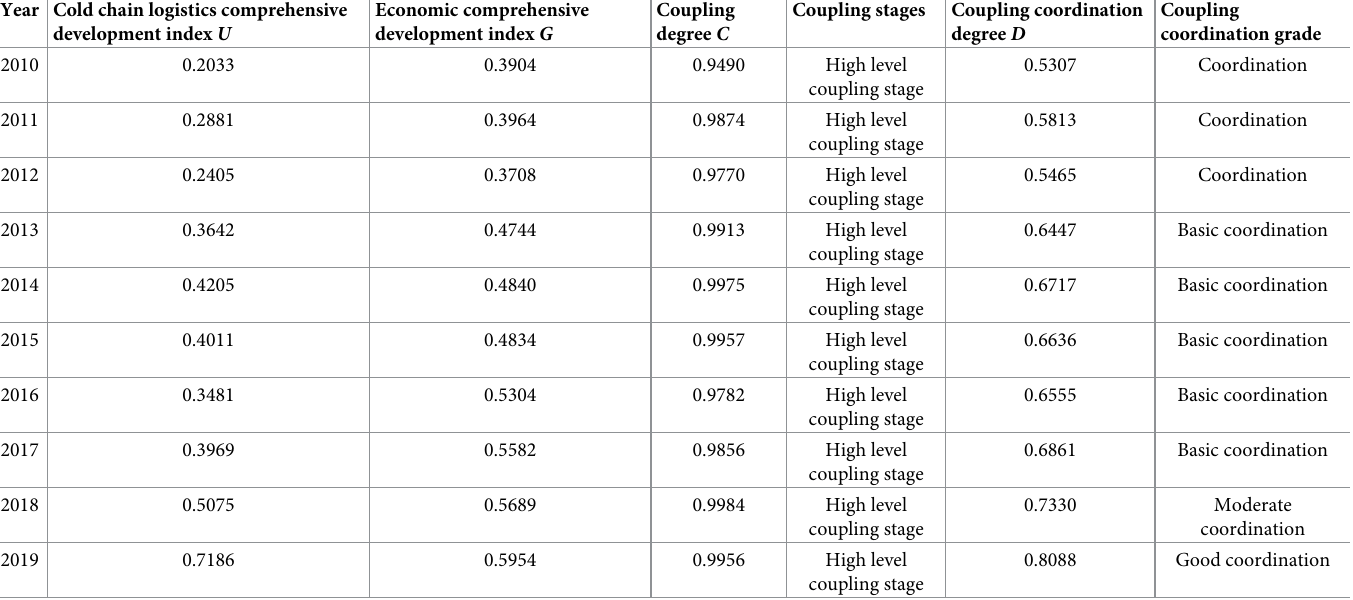
Table 6. Evaluation results for coupling relationship between cold chain logistics and